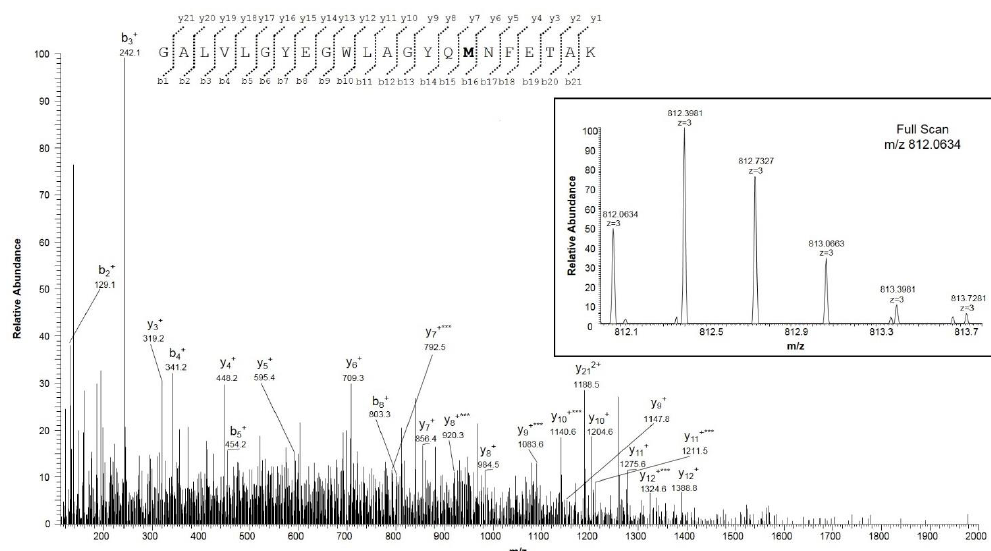
Figure 3. MS / MS spectrum of the triply charged molecular ion at m / z 812.0634 (calculated 812.0635) of the VDAC1 tryptic peptide from HAP1 cells containing methionine residue 155 in the oxidized form of methionine sulfoxide. The inset shows the full scan mass spectrum of molecular ion. Fragment ions originated from the neutral loss of methanesulfenic acid (CH 2 SOH, 64 Da) are indicated by three asterisks.